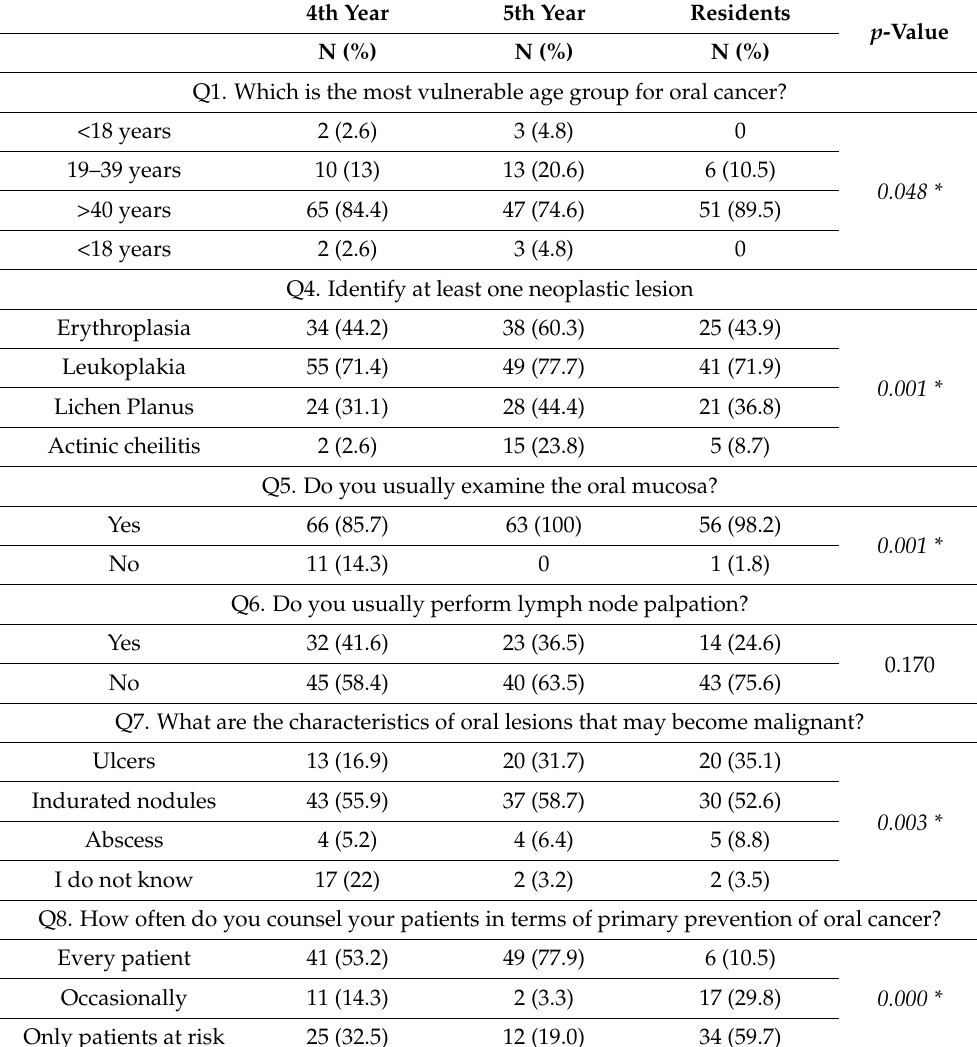
Table 2. Assessment of oral cancer practice and continuing education among participants. 4th Year 5th